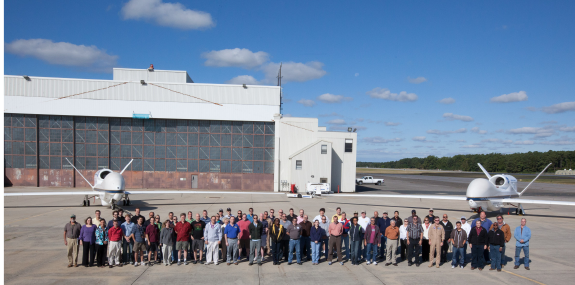
Figure 9. Two Global Hawks operated from Wallops